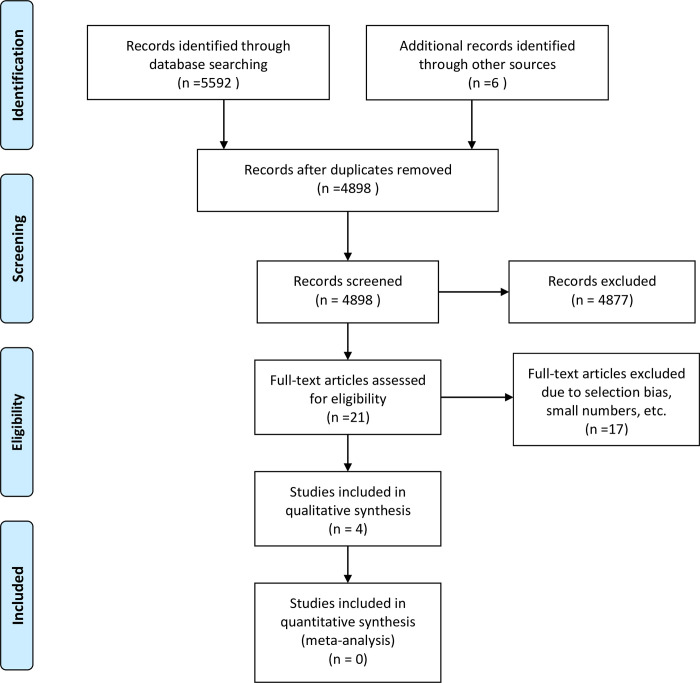
PRISMA flow Diagram of the identification process for the sample of articles addressing radiographic osteopenia or normal references for cortical thickness of the skeleton in children between 0 and 2 years of age.